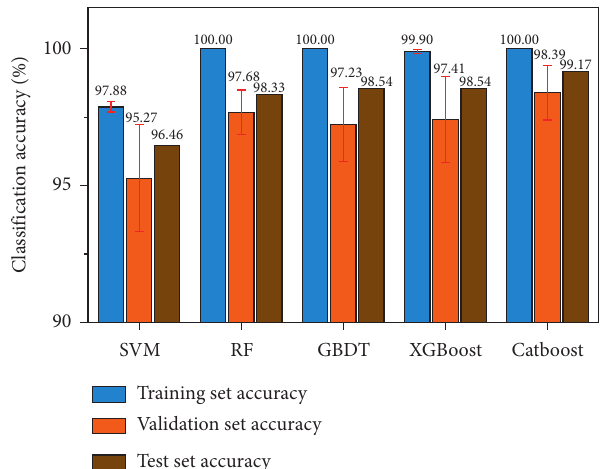
Figure 13: Comparison of classification accuracy of different classifiers.